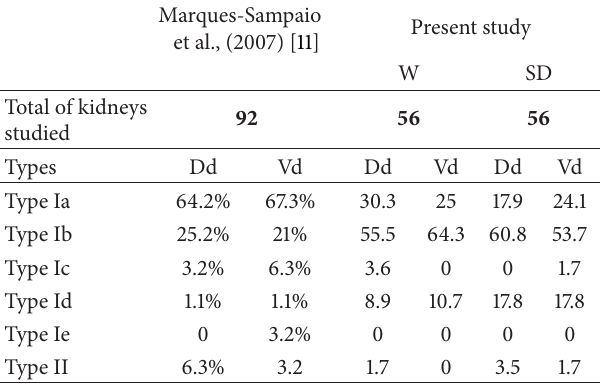
Table 3: Shows the study carried out by Marques-Sampaio et al. (2007) [11] to study the variations of the dorsal division (Dd) and ventral division (Vd) of the renal artery and their respective findings were compared to the present